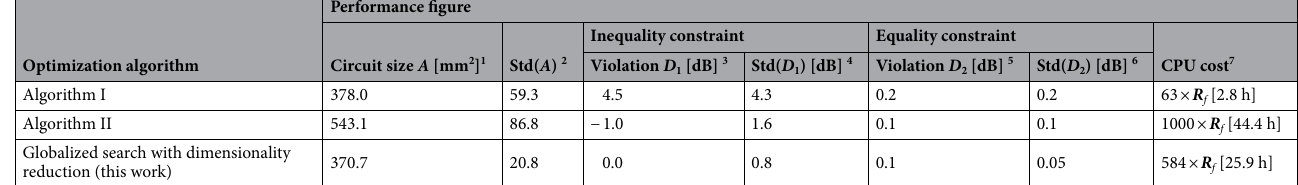
Table 7. Optimization results for Circuit II. 1 Optimized footprint area of the circuit averaged over ten algorithm runs. 2 Standard deviation of the optimized footprint area averaged over ten algorithm runs. 3